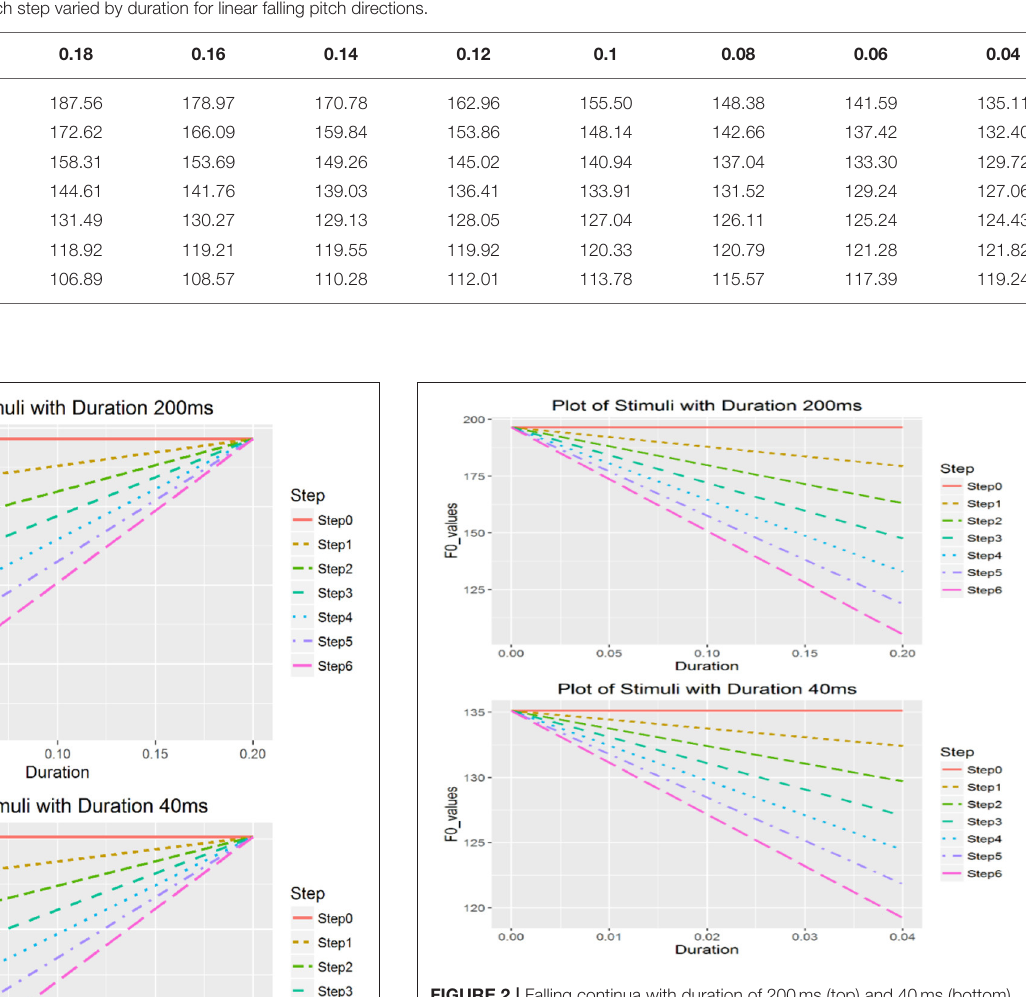
FIGURE 2 | Falling continua with duration of 200ms (top) and 40ms (bottom).